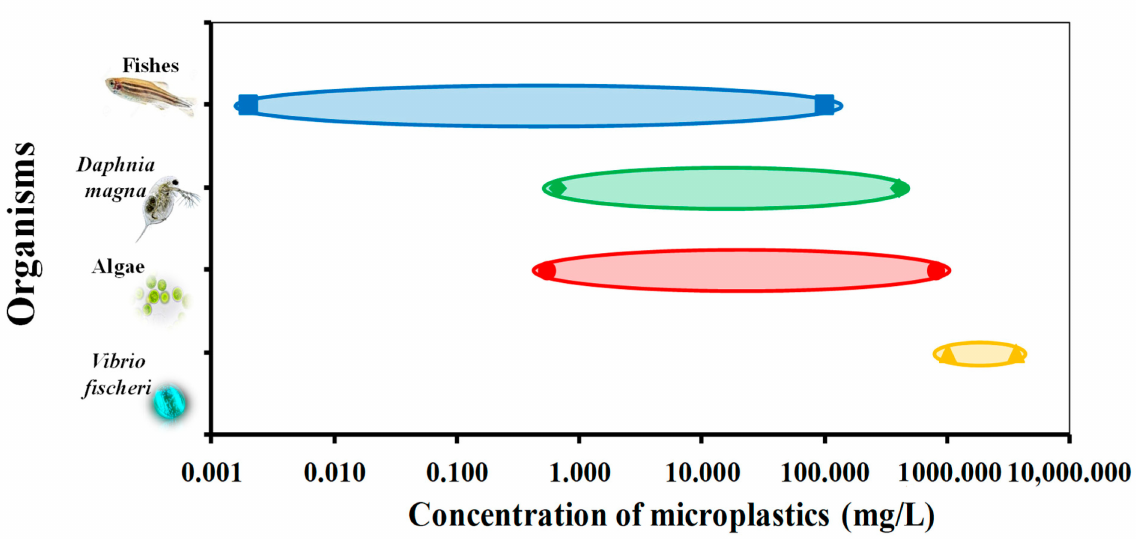
Figure 3. The range of ecotoxicological concentrations for different organism